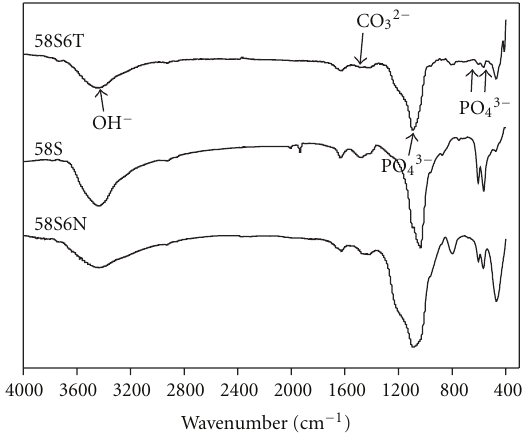
Figure 5: Transmittance FTIR spectra on the surfaces of the 58S, 58S6N, and 58S6T after immersion in SBF for 5